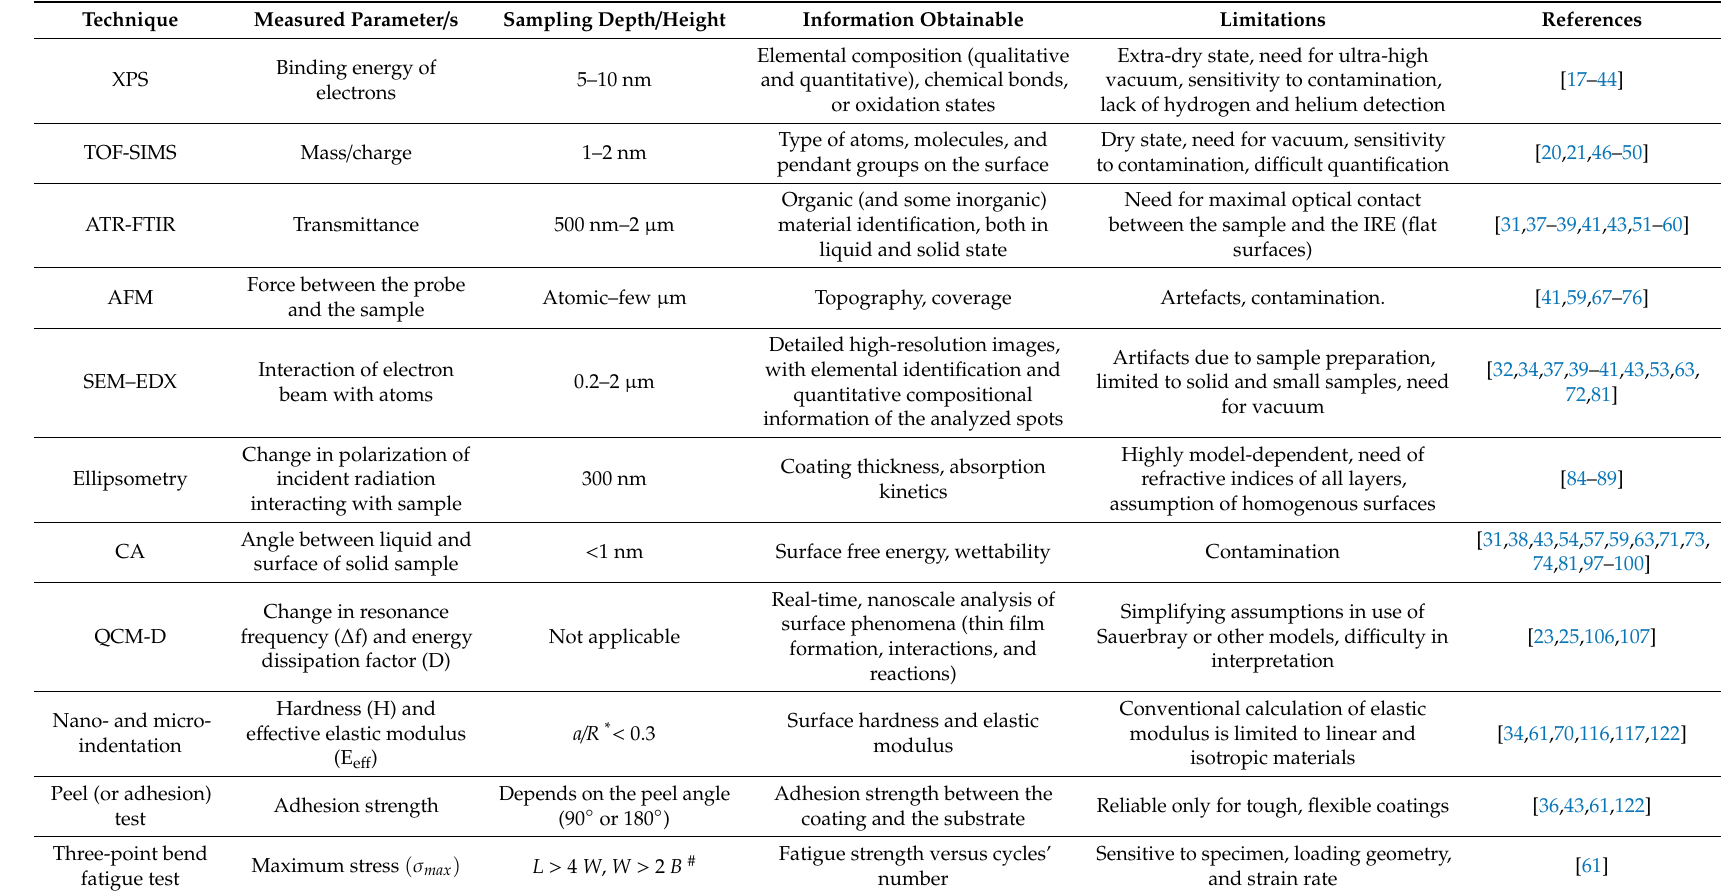
Table 1. The main analytical and mechanical techniques for coating